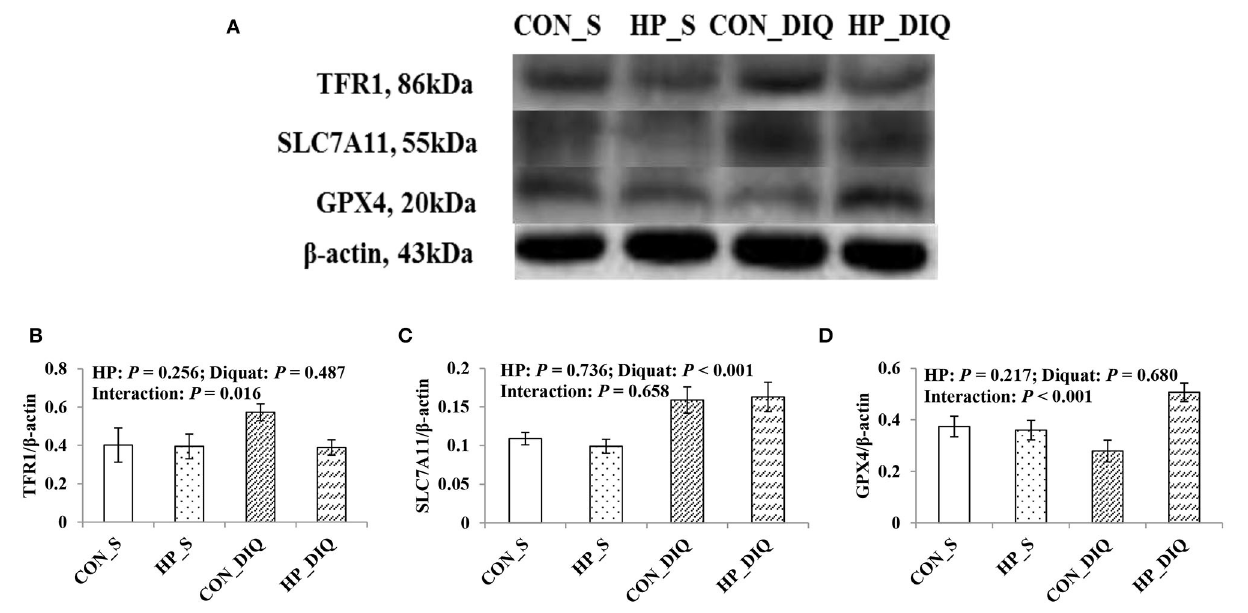
FIGURE 3 | The effect of dietary holly polyphenols extracts (HPE) on protein expression of TFR1 (B) , SLC7A11 (C) , and GPX4 (D ) of weaned pigs after 7 d diquat challenge. The bands were the representative Western blot images (A) . Values are mean and pooled SEM, n = 8 (1 pig/pen). CON_S, piglets fed the basal diet and injected with saline; HP_S, piglets fed HPE diet and injected with saline; CON_DIQ, piglets fed the basal diet and challenged with diquat; HP_DIQ, piglets fed HPE diet and challenged with